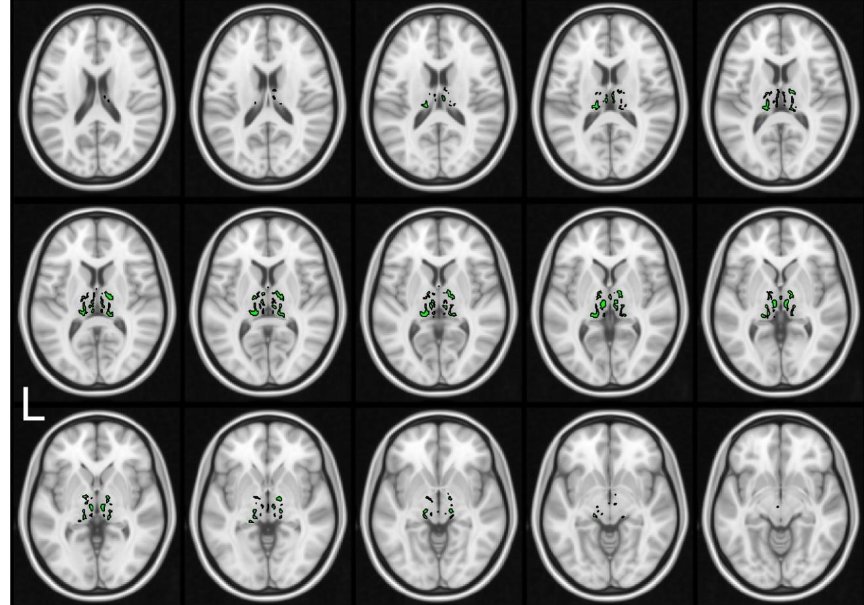
Figure 2. Iron accumulation regions are shown as contoured green overlaid on the brain T1-weighted MNI152 atlas image. Regions were located within the thalami of patients with AGU using a voxel-wise permutation test, demonstrating that the iron accumulation is not uniform within thalamus but concentrates in specific